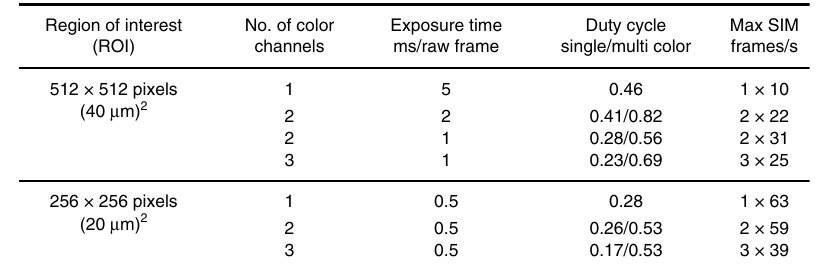
Fig. 2 Timing diagram and overview of achievable frame rates. a The diagram shows the intricate timing of all components (SLM, cameras, AOTF/Laser) during a high-speed SIM acquisition for two colors, with 1 ms exposure time and a 512 × 512 pixel ROI. The cameras have to be set to 520× 520, as explained in Supplementary Note 1. Illuminating the sample in one color channel while the camera of the other color channel is reading out its sensor gives a speedup over an image-splitter approach with only one camera. More detailed diagrams are shown in Supplementary Fig. 1 (two-color) and Supplementary Fig. 2 (three-color). b The table shows the highest achievable frame rates for a selection of different combinations of imaging area, number of simultaneously imaged color channels and exposure times (rounded down to